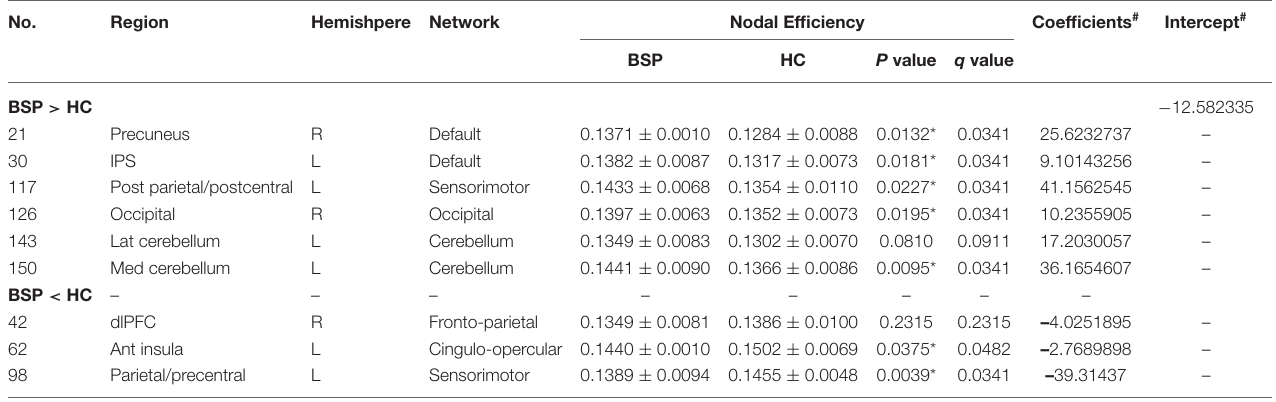
* Region considered abnormal. # Equation with dependent variables and the corresponding coefficients in the regression model. ant, anterior; BSP, blepharospasm; dlPFC, dorsolateral prefrontal cortex; HC, healthy control; IPS, intraparietal sulcus; L, left; lat, lateral; med, medial; post, posterior; R,